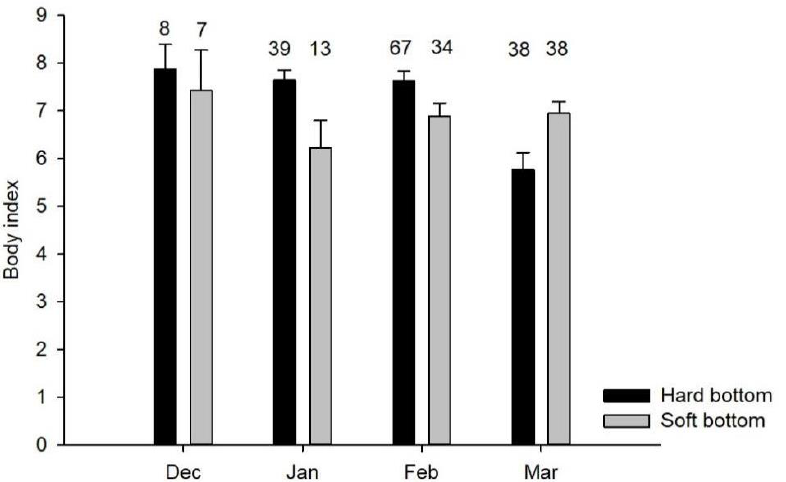
Figure 4. Long-tailed duck body index variation in two bottom types from December to May. Sample size is denoted by labels above histogram columns. Error bars represent the standard error of the mean.